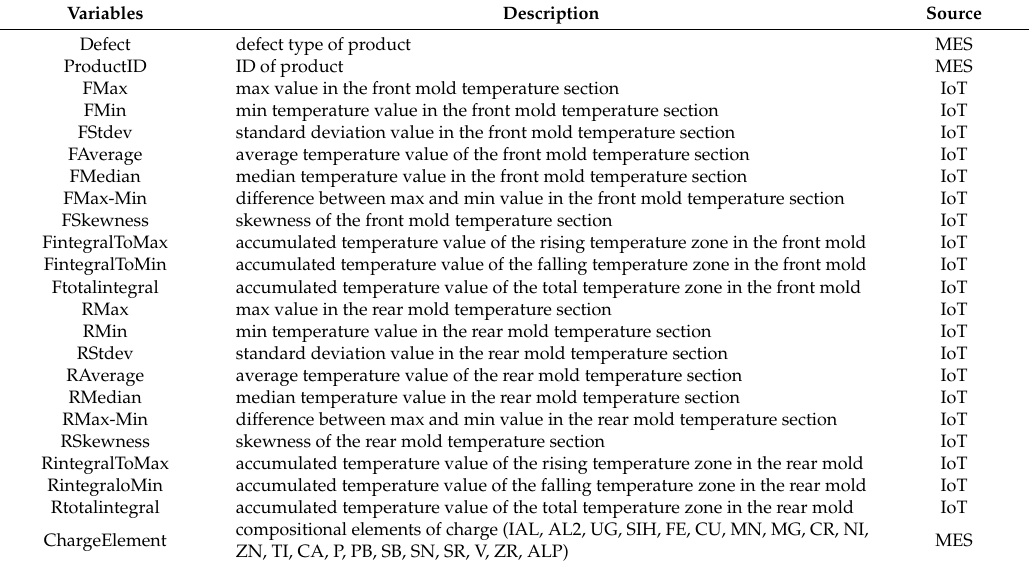
Table 4. Input variables for quality prediction.